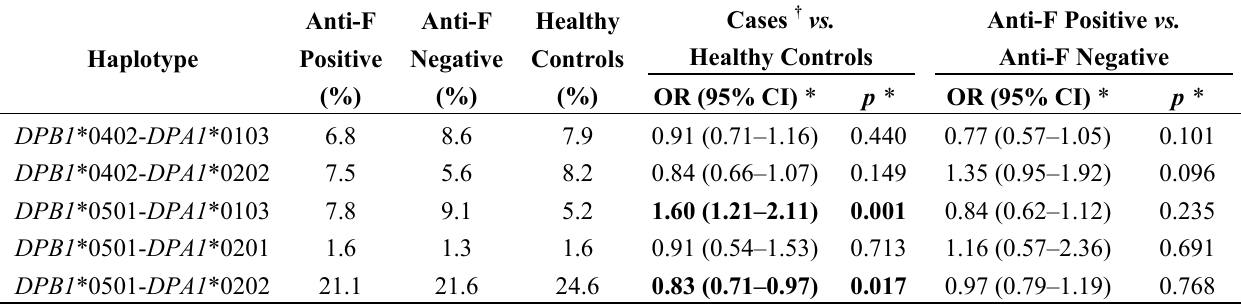
Table 6. Distribution of HLA-DPA1-HLA-DPB1 haplotypes among the group of anti-F negative patients, anti-F positive patients and healthy